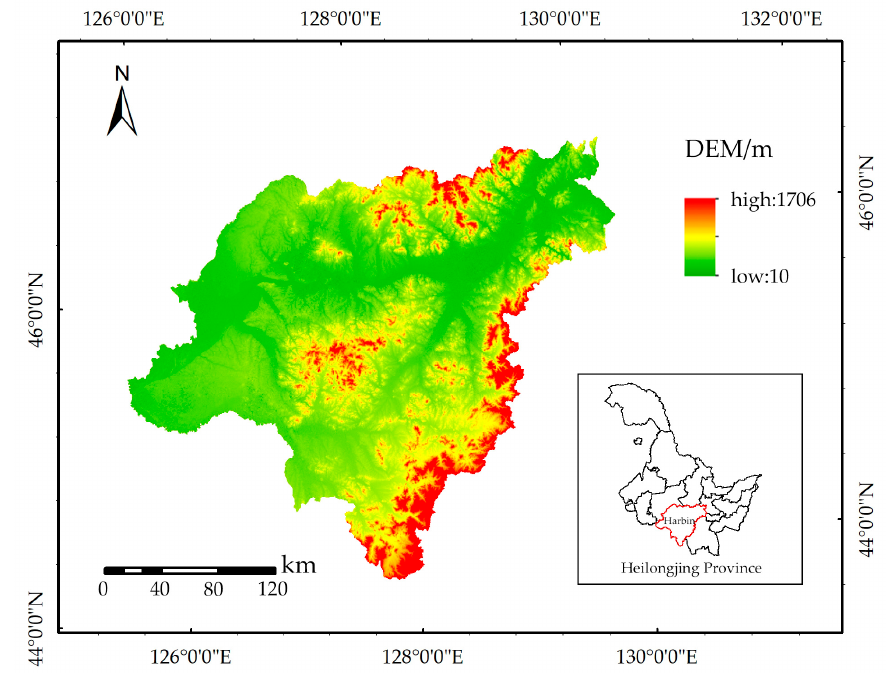
Figure 1. Geographical location and DEM map of the study region in 2020.